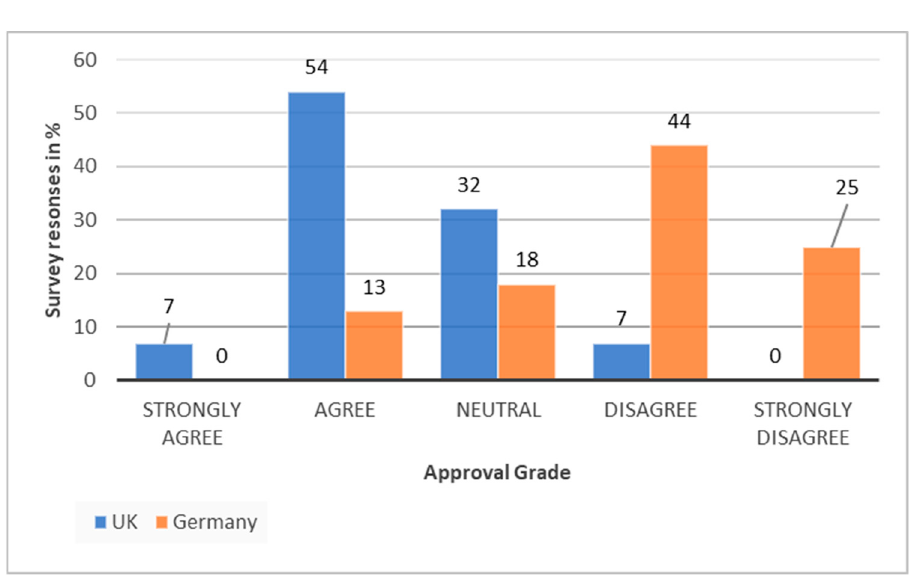
Figure 6. Comparison of the UK’s and Germany’s survey responses about the governance approach for sustainability.